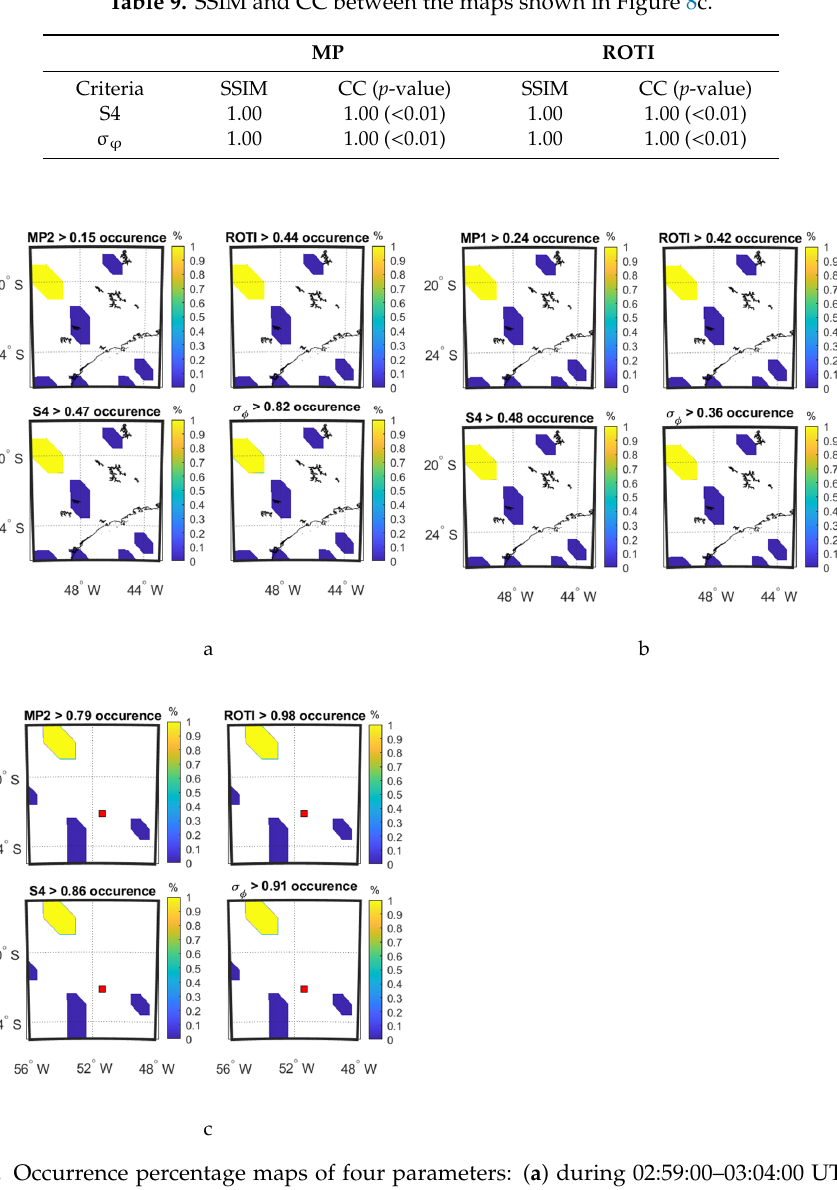
Table 9. SSIM and CC between the maps shown in Figure 8c.